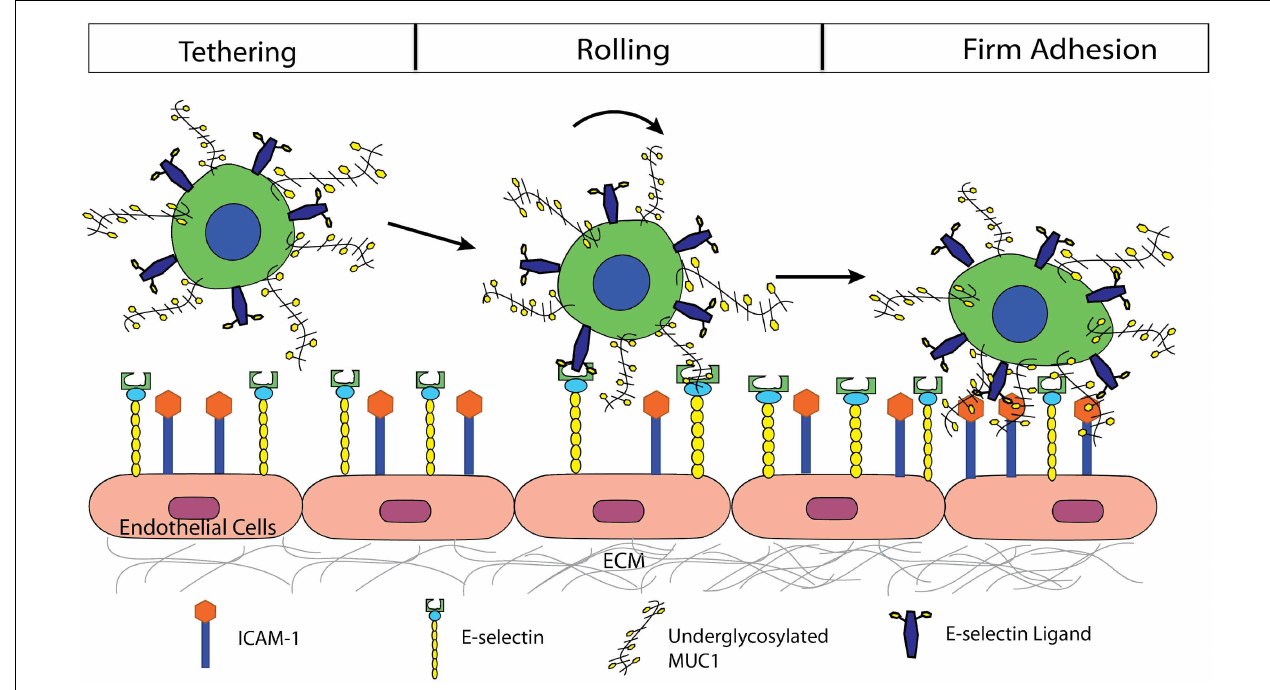
FIGURE 6 | Proposed mechanism by which MUC1 can act as a ligand for E-selectin, initiating tethering, and rolling events of CTCs on the endothelium, and subsequently serve as an ICAM-1 ligand, mediating firm adhesion of CTCs.